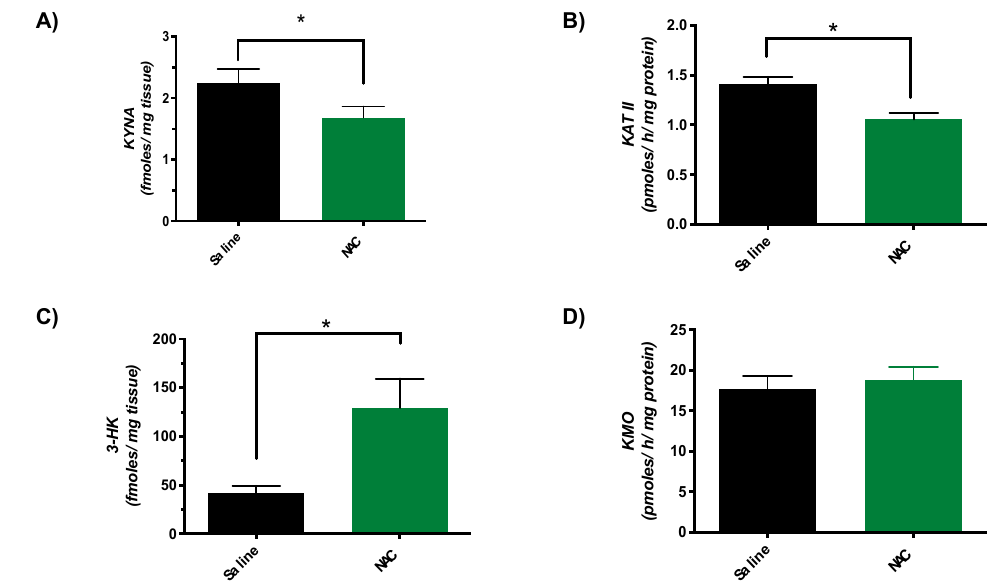
Figure 2. KYNA levels ( A ), KAT II activity ( B ), 3-HK levels ( C ), and KMO activity ( D ) in the brain (cortex) of mice after subchronic administration of NAC (100 mg/kg/day) or saline. See Materials and Methods for experimental details. Data are the mean ± SEM of 10 animals per group, * p < 0.05 vs. saline (pairwise comparisons, Mann–Whitney